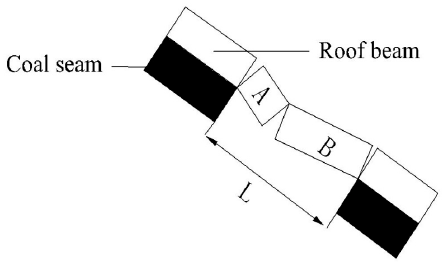
Figure 3. Diagram of roof fracture structure.